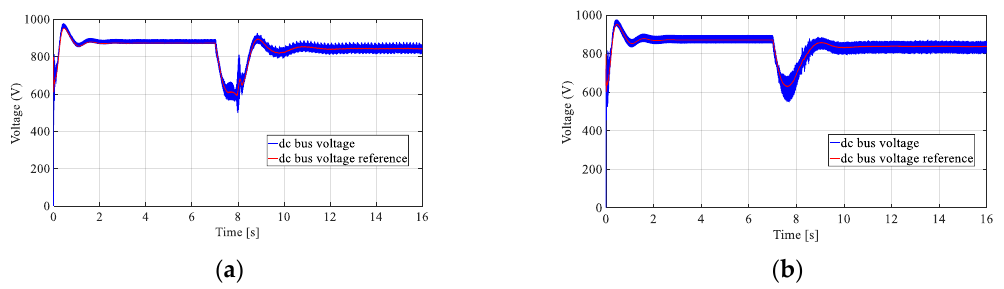
Figure 9. dc bus voltage: ( a ) CMPPT control; ( b ) DMPPT control.